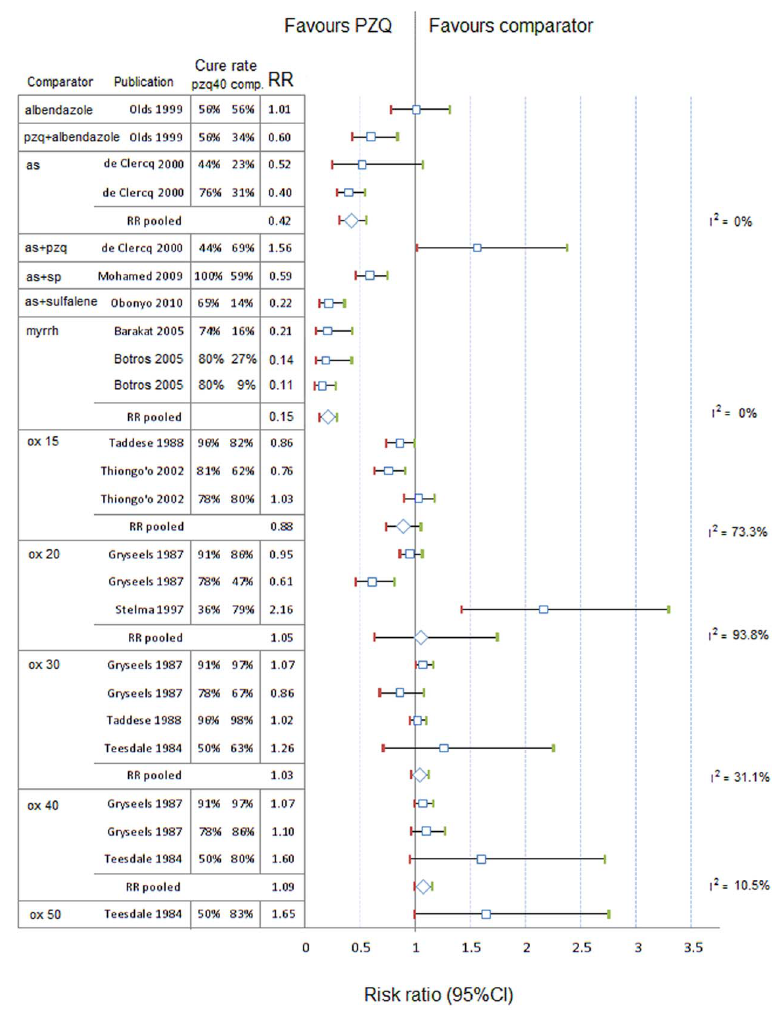
Figure 5. Forest plot of risk ratio of cure rates with 95%CIs, S. mansoni, PZQ 40 mg/kg vs. other regimens. as, artesunate; ox, oxamniquine; pzq, praziquantel; sp, sulfadoxine-pyrimethamine; mq, mefloquine; comp, comparator; ci, confidence interval; unit next to the drug: dose in mg/kg; RR, risk ratio; I 2 (Higgins’ I squared) is calculated for pooled subgroups as = 100% 6 ( Q - df)/ Q , where Q is Cochran’s heterogeneity statistic and df the degrees of